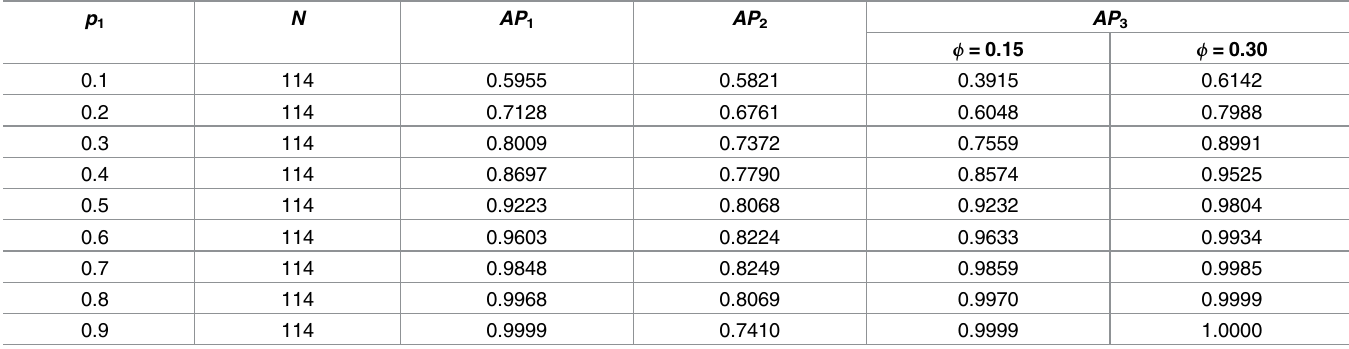
Table 3. Sample size and assurance probabilities for observing criteria (i), (ii), and (iii) given α = 0.025, β = 0.1, ( Δ 1 , Δ 2 ) = (3,0.45), ( σ 1 , σ 2 ) = (6,1), ( γ 1 , γ 2 ) = (0.5, 0.5), and ρ 12 =